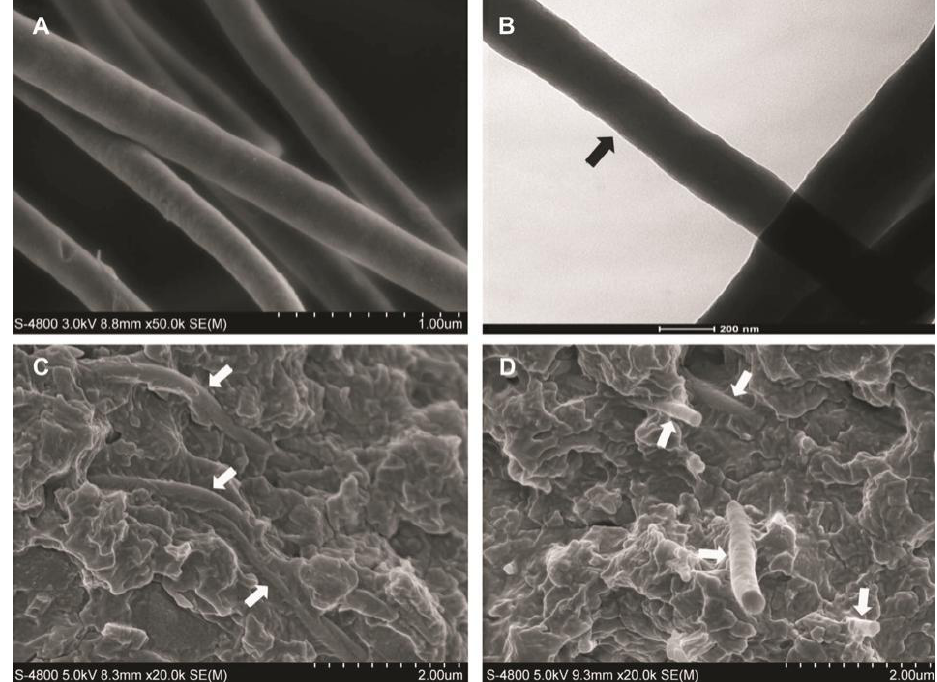
Figure 13. Morphology of electrospun ZY@S nanofibers: ( A ) SEM image (fiber diameter: 260 ± 39 nm) and ( B ) TEM image showing the core-sheath structure. Morphology of the composite fracture surface with ( C ) 2.5 wt% ZY@S nanofibers and ( D ) 5.0 wt% ZY@S nanofibers.Images from [98].